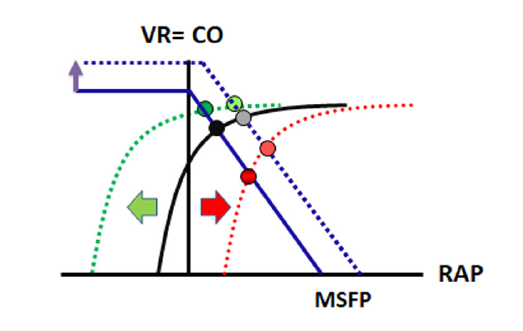
the venous return function curve (blue) and the Frank-Starling (cardiac output) curve (black). The intersection between these two curves in an equilibrated system is right atrial pressure.Venous re- turn reaches its maximum when the right atrial pressure (RAP) is near zero. The venous return function curve intersects the x axis at zero blood flow, where it represents the mean systemic filling pres- sures (MSFP). In the case of volume responsiveness, the VR func- tion curve is shifted upwards and to the right, and reaches a new equilibrium (dotted blue line with resulting grey RAP).With sponta- neous inspiration, pleural pressure and RAP drop (green arrow), while transmural RAP will rise. The Starling curve is shifted to the left (dotted green curve). A new equilibrium point is reached